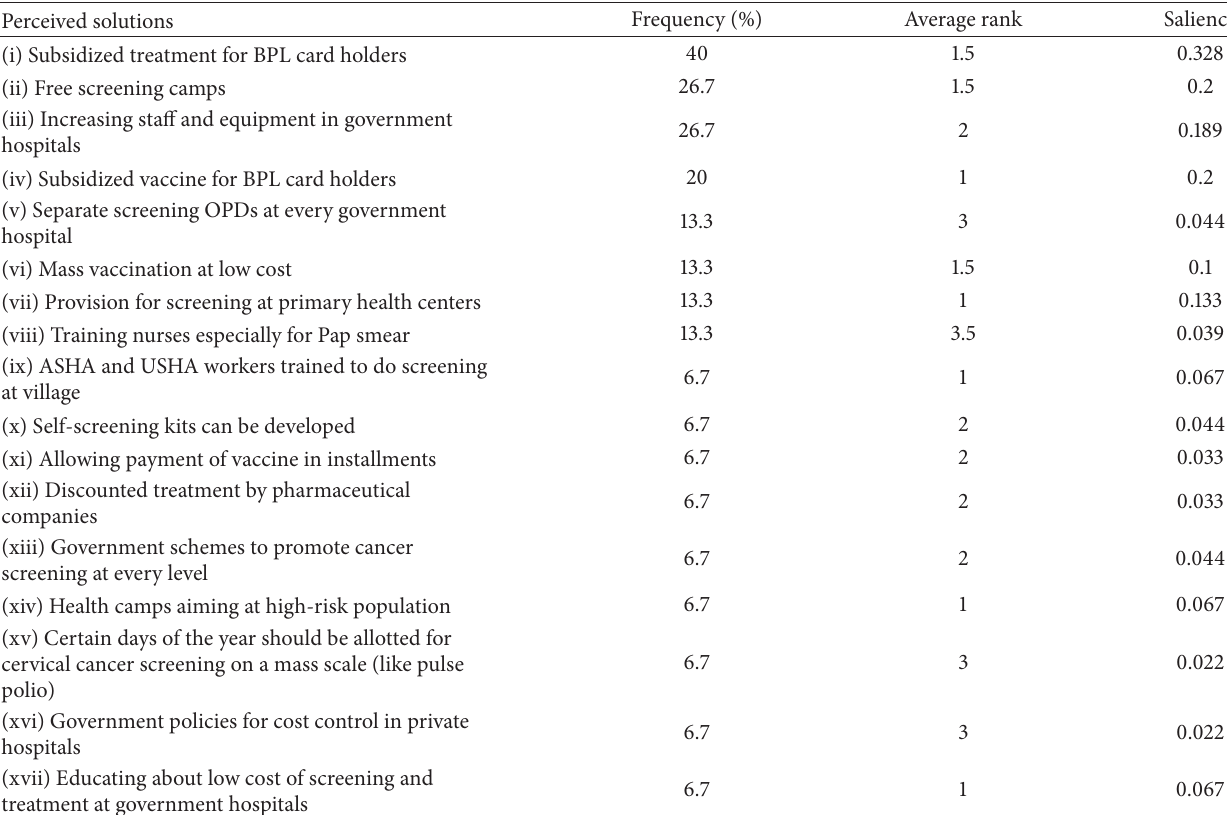
Table 10: Perceived solutions for “resource constrains and affordability